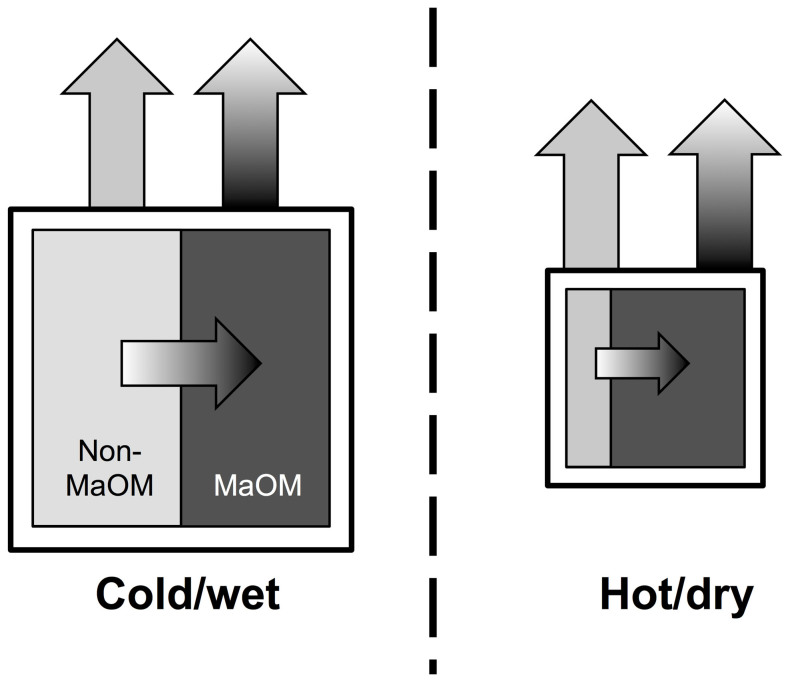
Conceptual model of a hypothesis to explain the higher δ15N of soils from hot and/or dry ecosystems.Hot and/or dry ecosystems might not have a greater proportion N lost to fractionating (gradient arrow) vs. non-fractionating (solid arrow) losses. Note, arrows not to scale. Instead, as a result of having organic matter that has been decomposed to a greater degree and/or greater clay concentrations, soils from hot and/or dry ecosystems might simply have a greater proportion of their N in mineral-associated organic matter, which is enriched in 15N relative to non-mineral-associated organic matter.